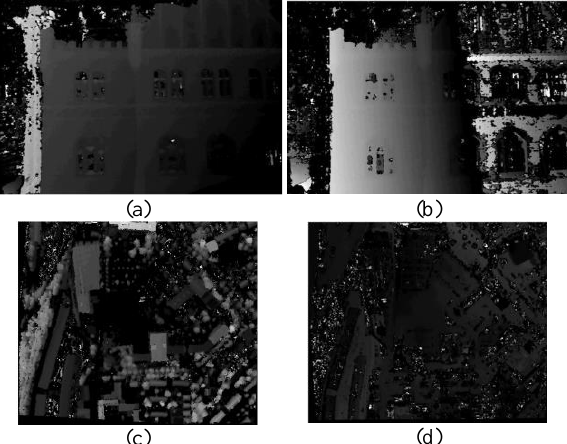
Figure 10. Disparity maps obtained with SGM after image rectification. (a) First image pair, rectification using the proposed method. (b) First image pair, rectification using the SURF+RANSAC. (c) Third image pair, rectification using the proposed method. (d) Third image pair, rectification using the